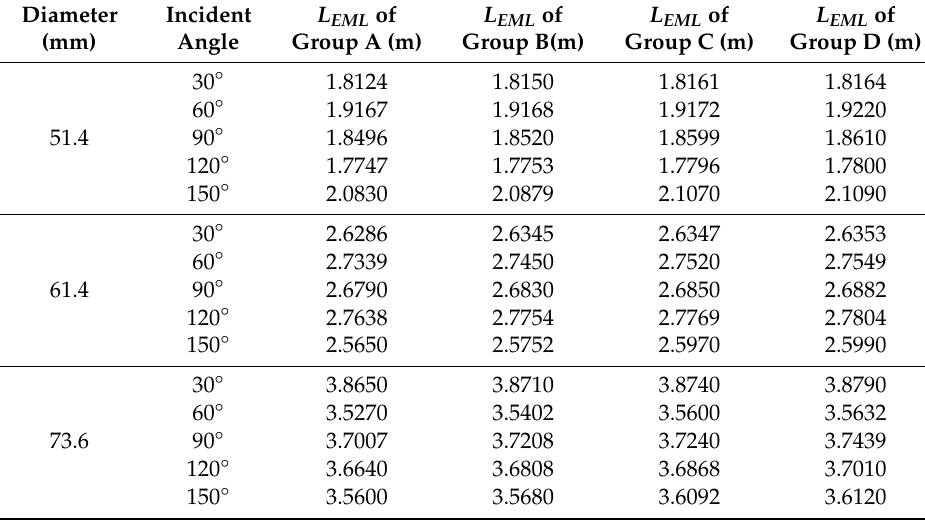
Table 3. Comparison of L EML under di ff erent diameters and incident